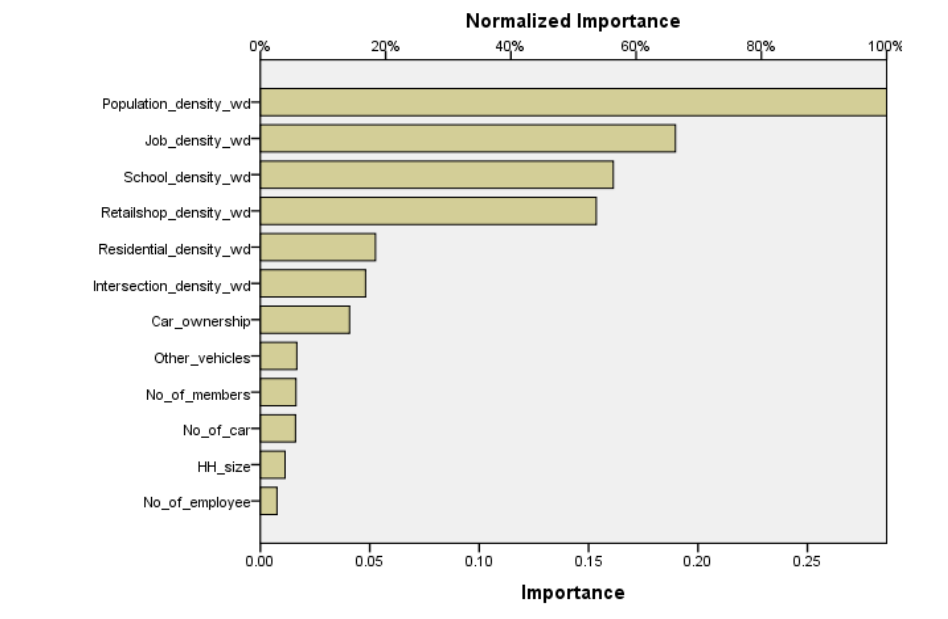
Figure 14. Normalized importance.